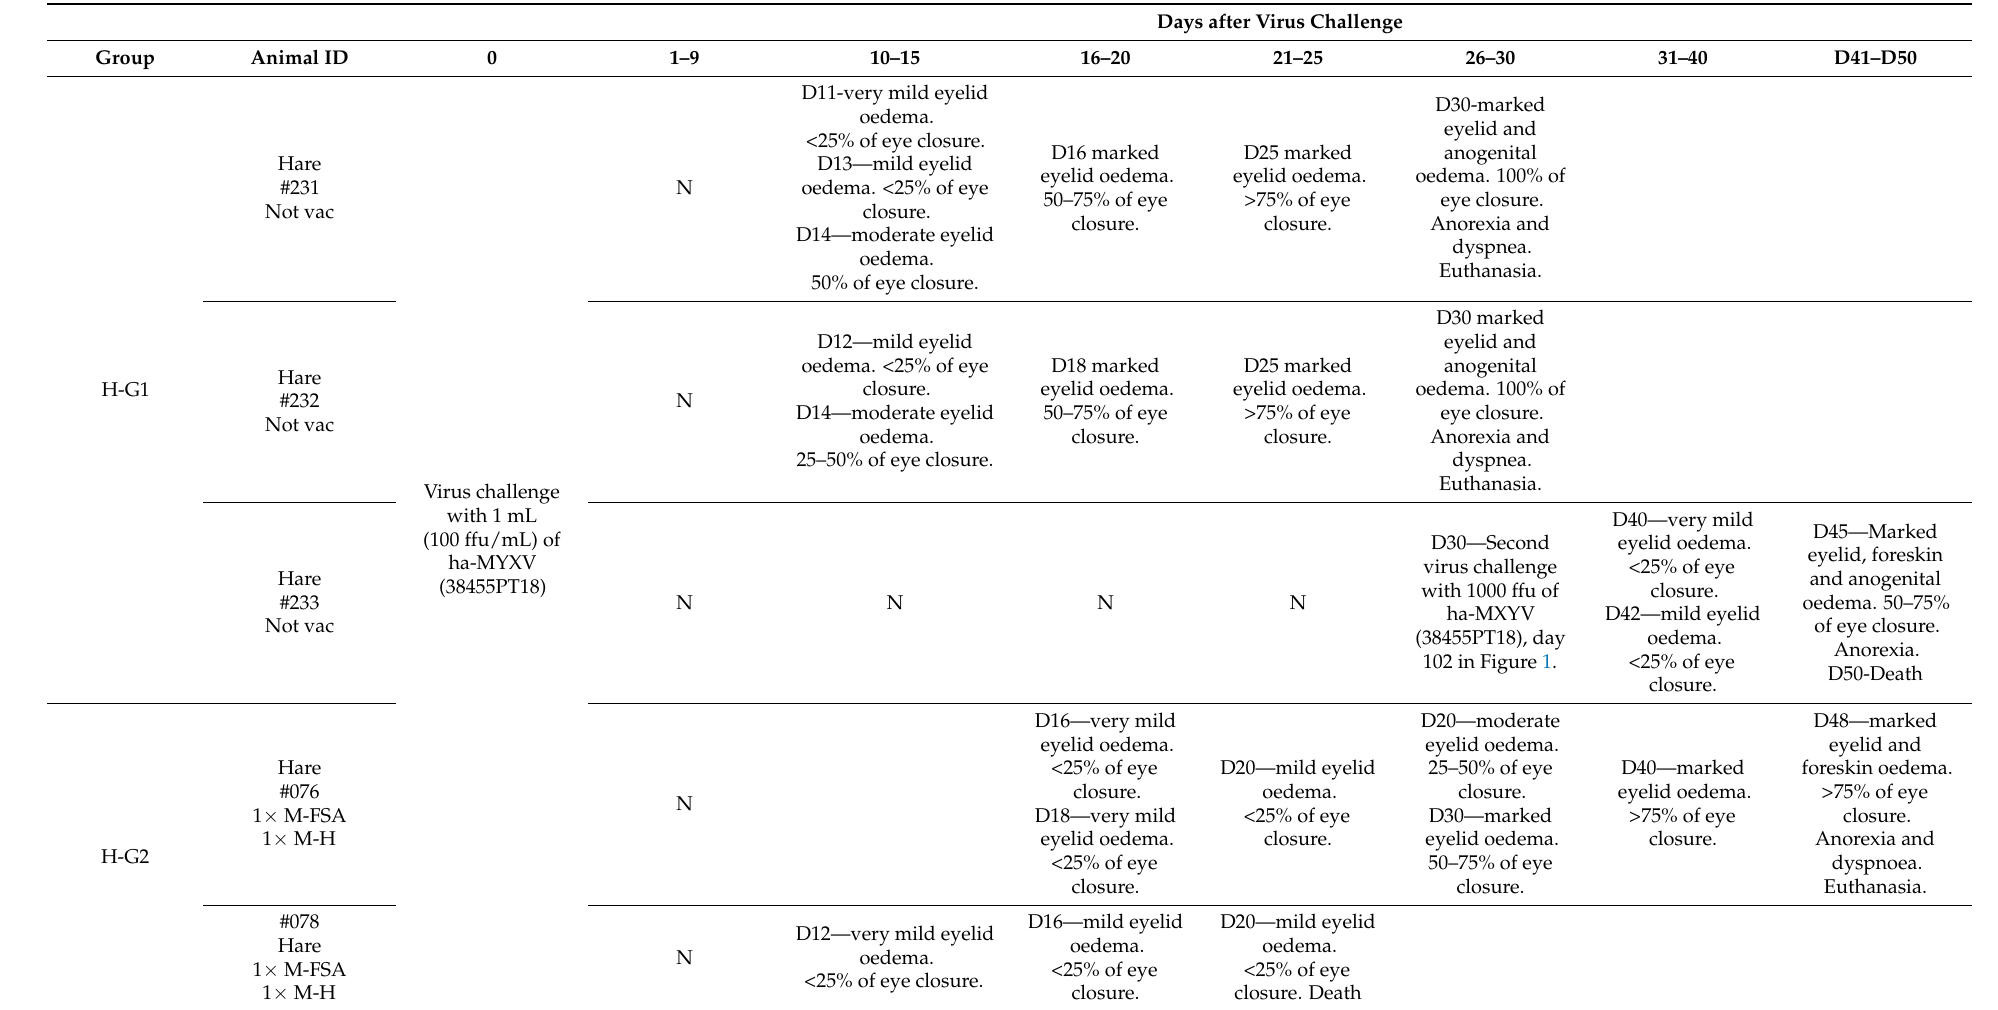
Table 3. Clinical data of Iberian hares after challenge with ha-MYXV